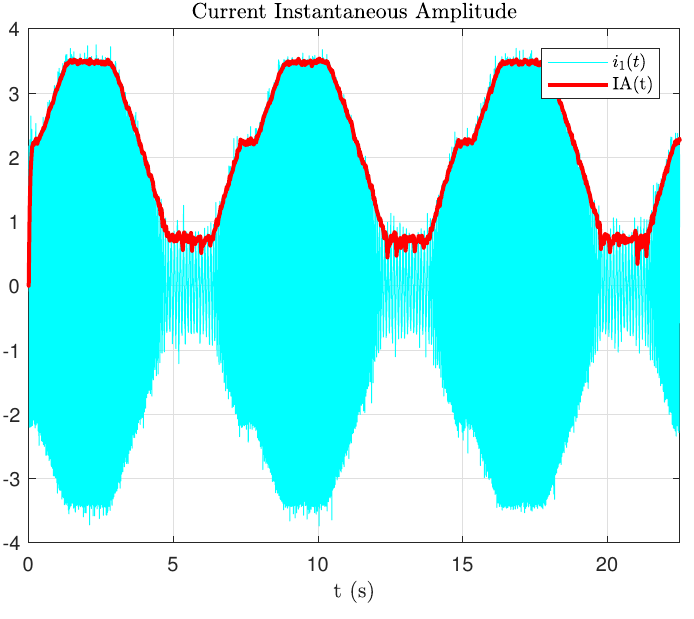
Figure 7. Phase current i 1 ( t ) and IA ( t ) , m 1 =